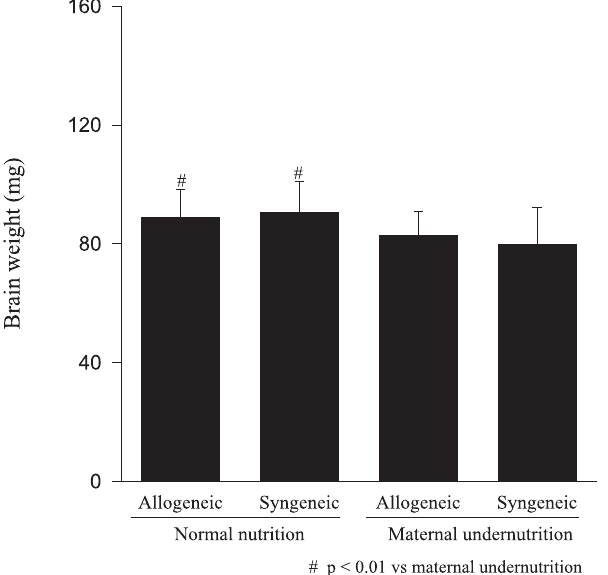
Figure 4 - Effect of type of maternal diet and maternal-fetal genetic compatibility on fetal liver weight (mean ±